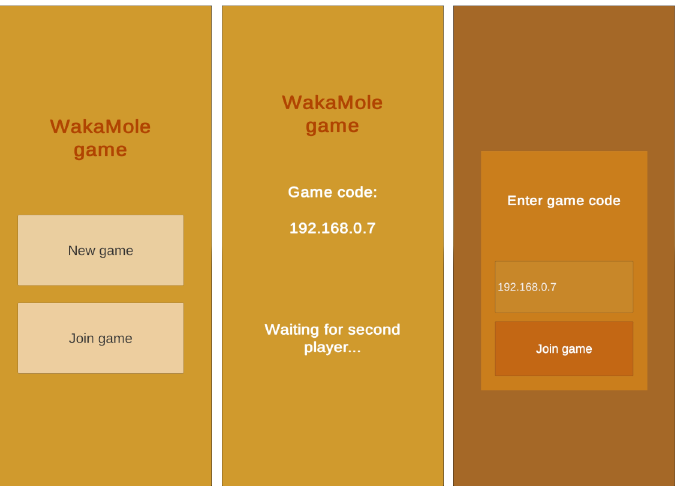
Figure 12. Overview of the Wakamole game matchmaking process: main menu ( left ), host screen ( center ) and client screen ( right